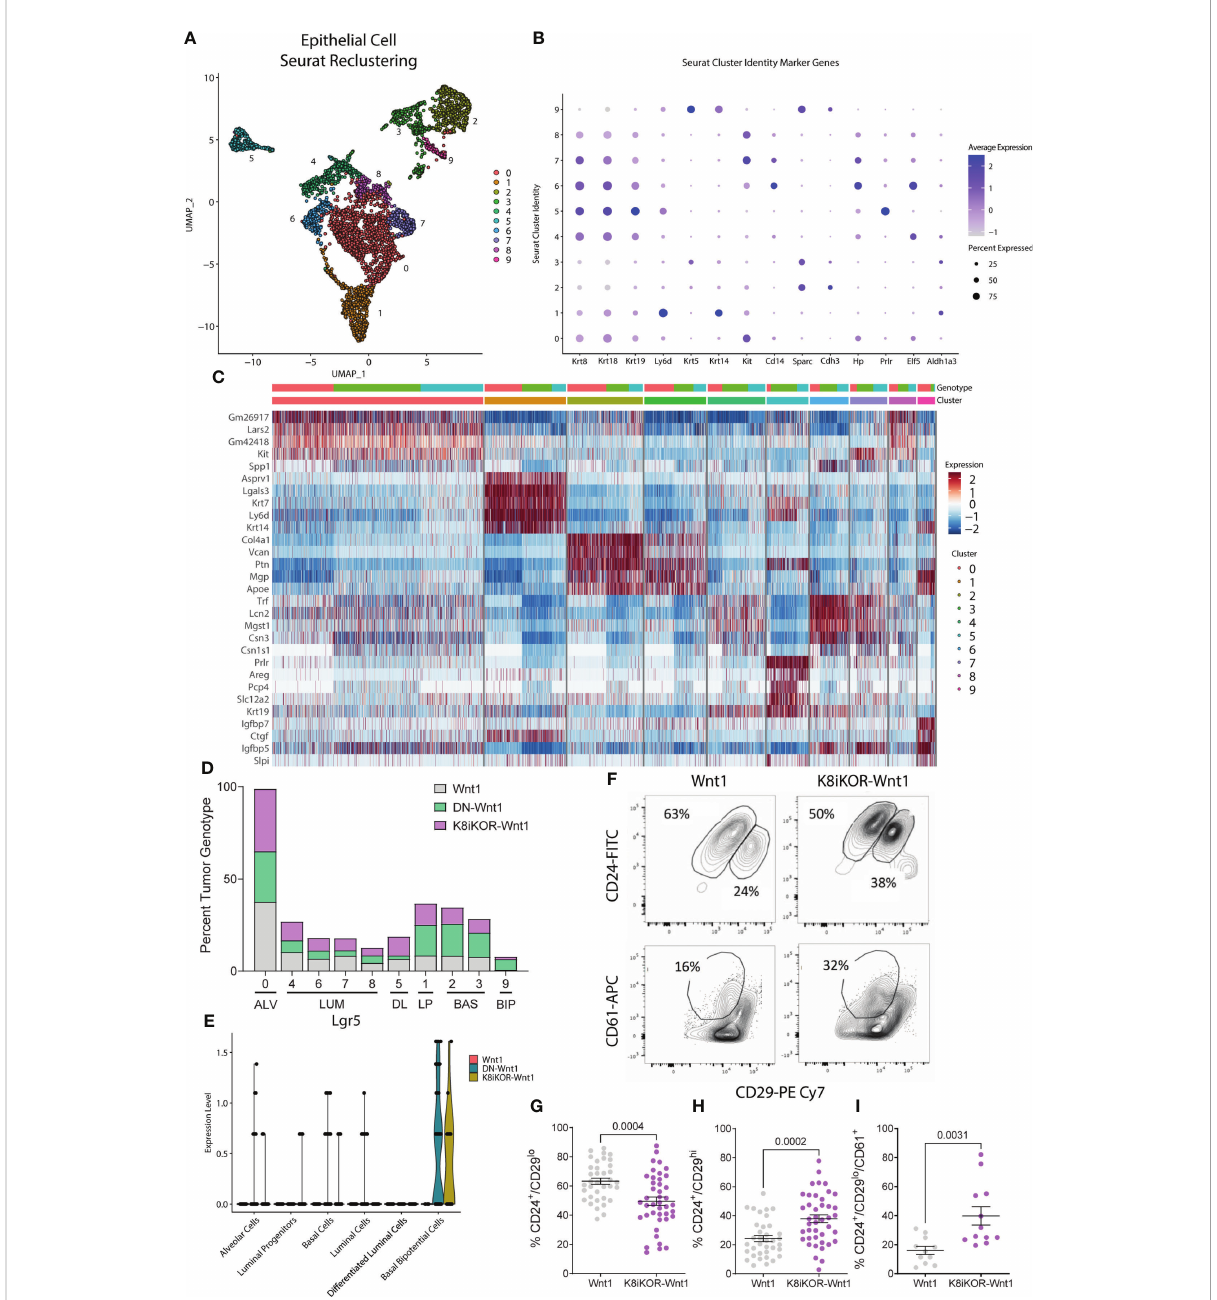
FIGURE 5 Epithelial cell populations are altered with reduced IGF1R. (A) UMAP plot of re-clustering of epithelial cells from Wnt1, DN-Wnt1, and K8iKOR- Wnt1 tumors resulting in 13 clusters. (B) Dot plot of epithelial cell markers. (C) Heat map of top epithelial cell type markers. Top legend: top row=tumor identity: red=Wnt1, green=DN-Wnt1, blue=K8iKOR-Wnt1; Bottom row=epithelial cell cluster. (D) Percent tumor genotype graph for each cell cluster labelled with each cell type de fi ned by markers. (ALV=alveolar cell, LUM=luminal cell, DL=differentiated luminal cell, LP=luminal progenitor, BAS=basal cell, BIP=basal bipotential progenitor). (E) Violin plot for Lgr5 in each annotated cluster and tumor type. (F) Representative contour plots of fl ow cytometry of the CD24 + /CD29 lo (luminal) and CD24 + /CD29 hi (basal) cell populations and CD24 + / CD29 lo /CD61 - (luminal progenitor) cell population in Wnt1 and K8iKOR-Wnt1 tumors. G-I. Quanti fi cation of luminal (G) , basal (H) , and luminal progenitor (I) populations in Wnt1 and K8iKOR-Wnt1 tumors. Each dot represents an individual tumor. Statistic: Unpaired Student ’ s t-